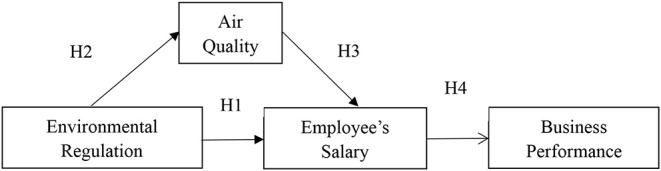
Research framework.